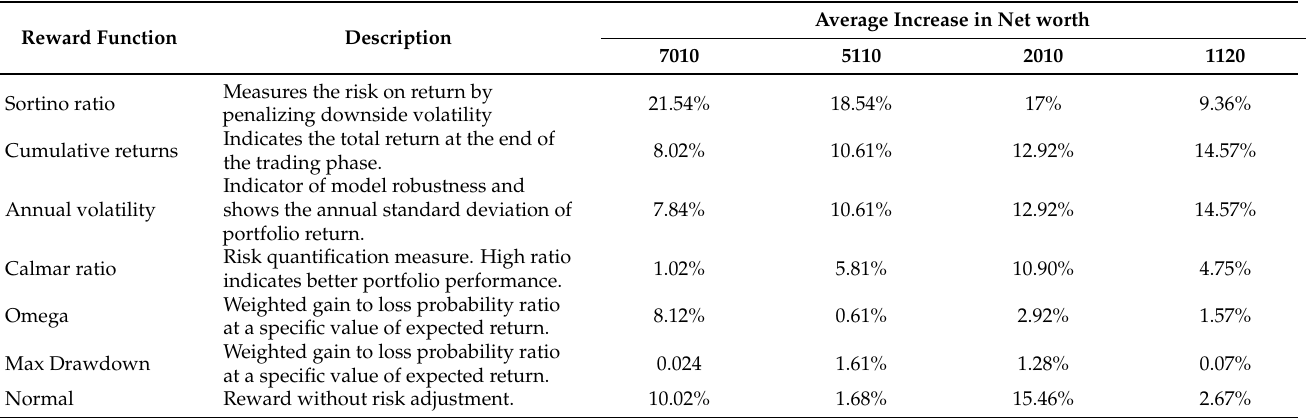
Table 4. Reward functions used in this work, in order of their performance (best to worst from top to